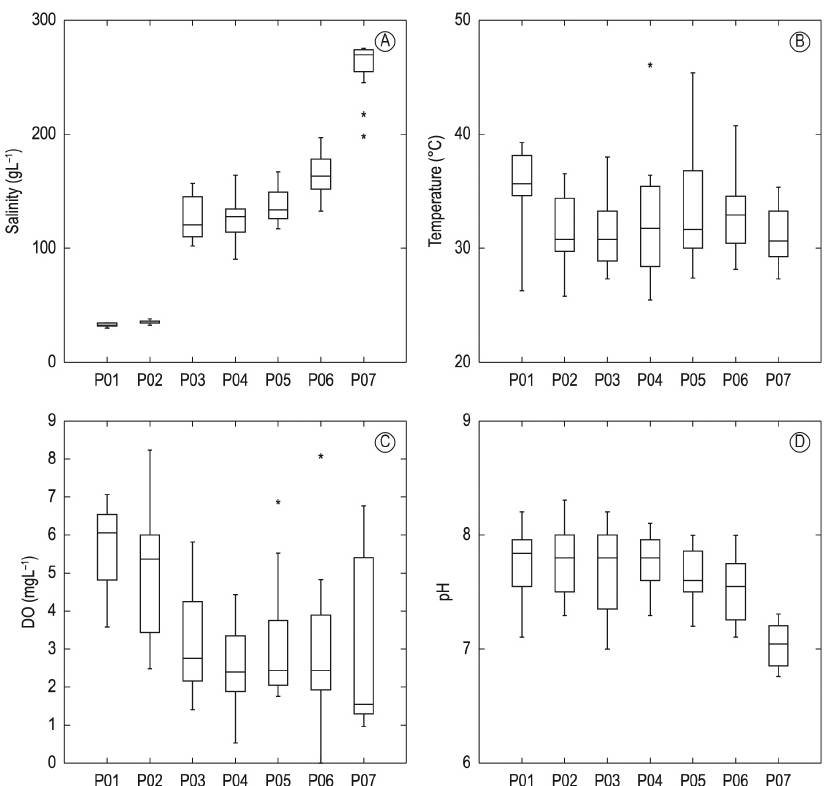
Figure 2. Spatial variation of salinity (A), temperature (B), pH (C) and dissolved oxygen (D) along the brine circuit on Salina Unidos. (*Extreme